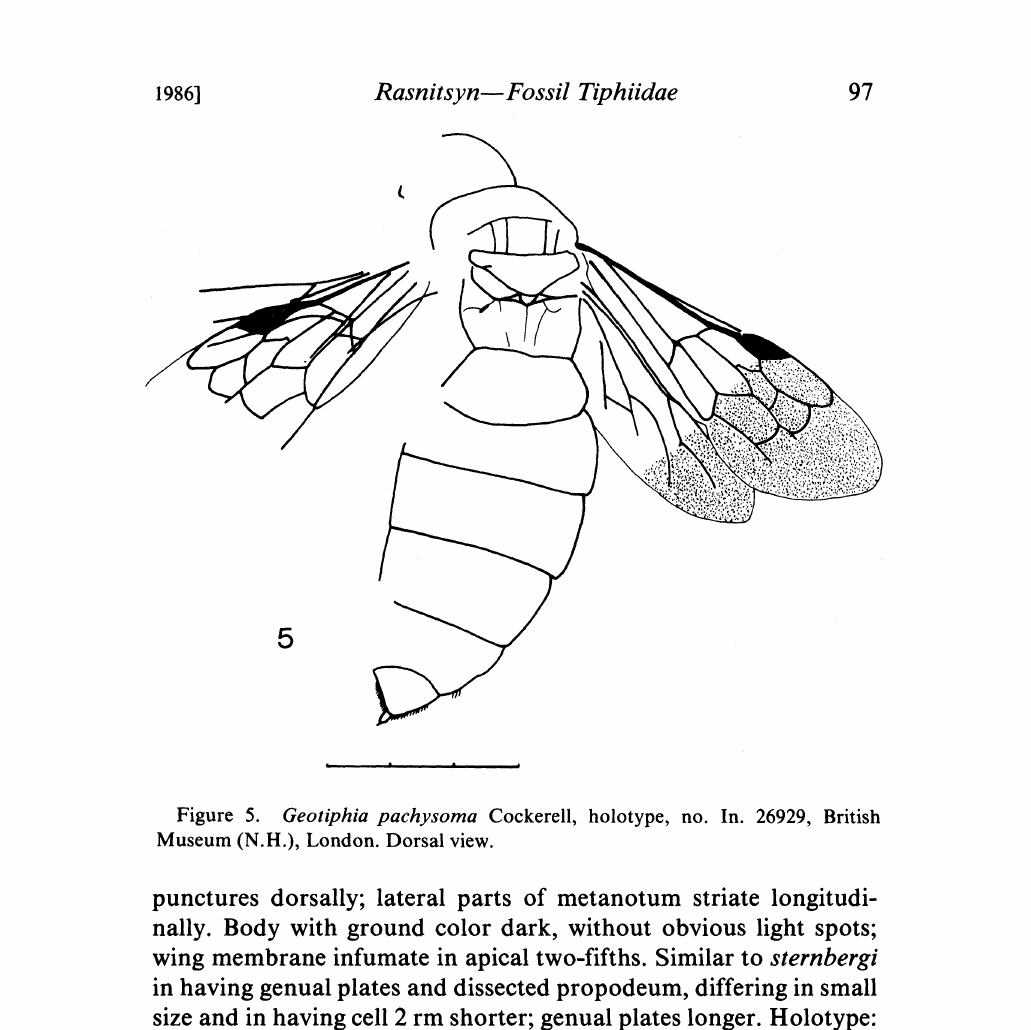
Figure 5. Geotiphia pachysoma Cockerell, holotype, no. In. 26929, British Museum (N.H.), London. Dorsal